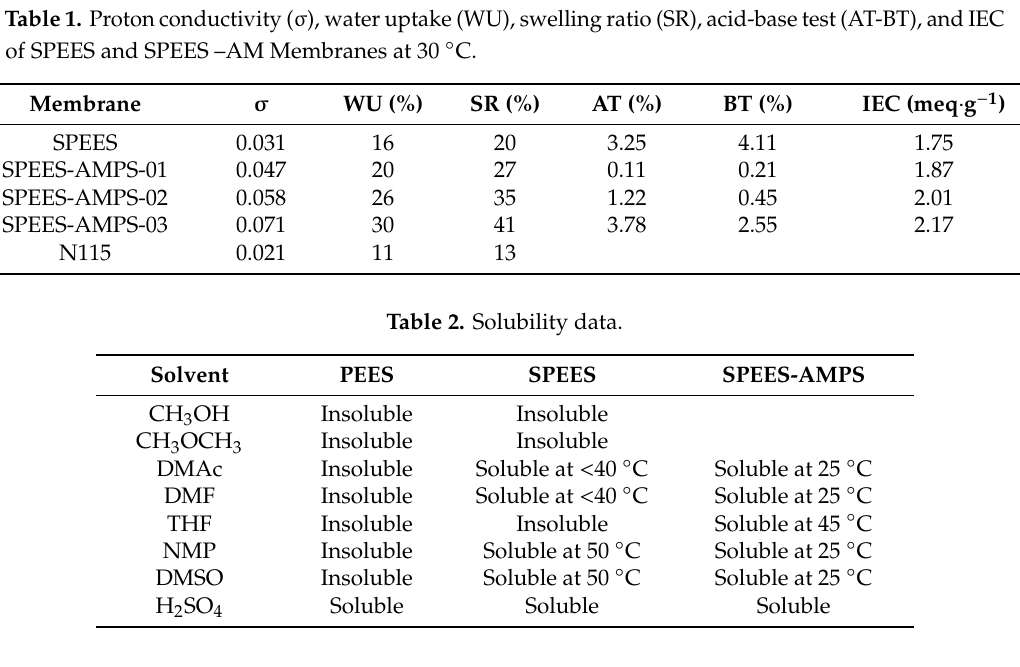
Table 1. Proton conductivity ( σ ), water uptake (WU), swelling ratio (SR), acid-base test (AT-BT), and IEC of SPEES and SPEES –AM Membranes at 30 °C.